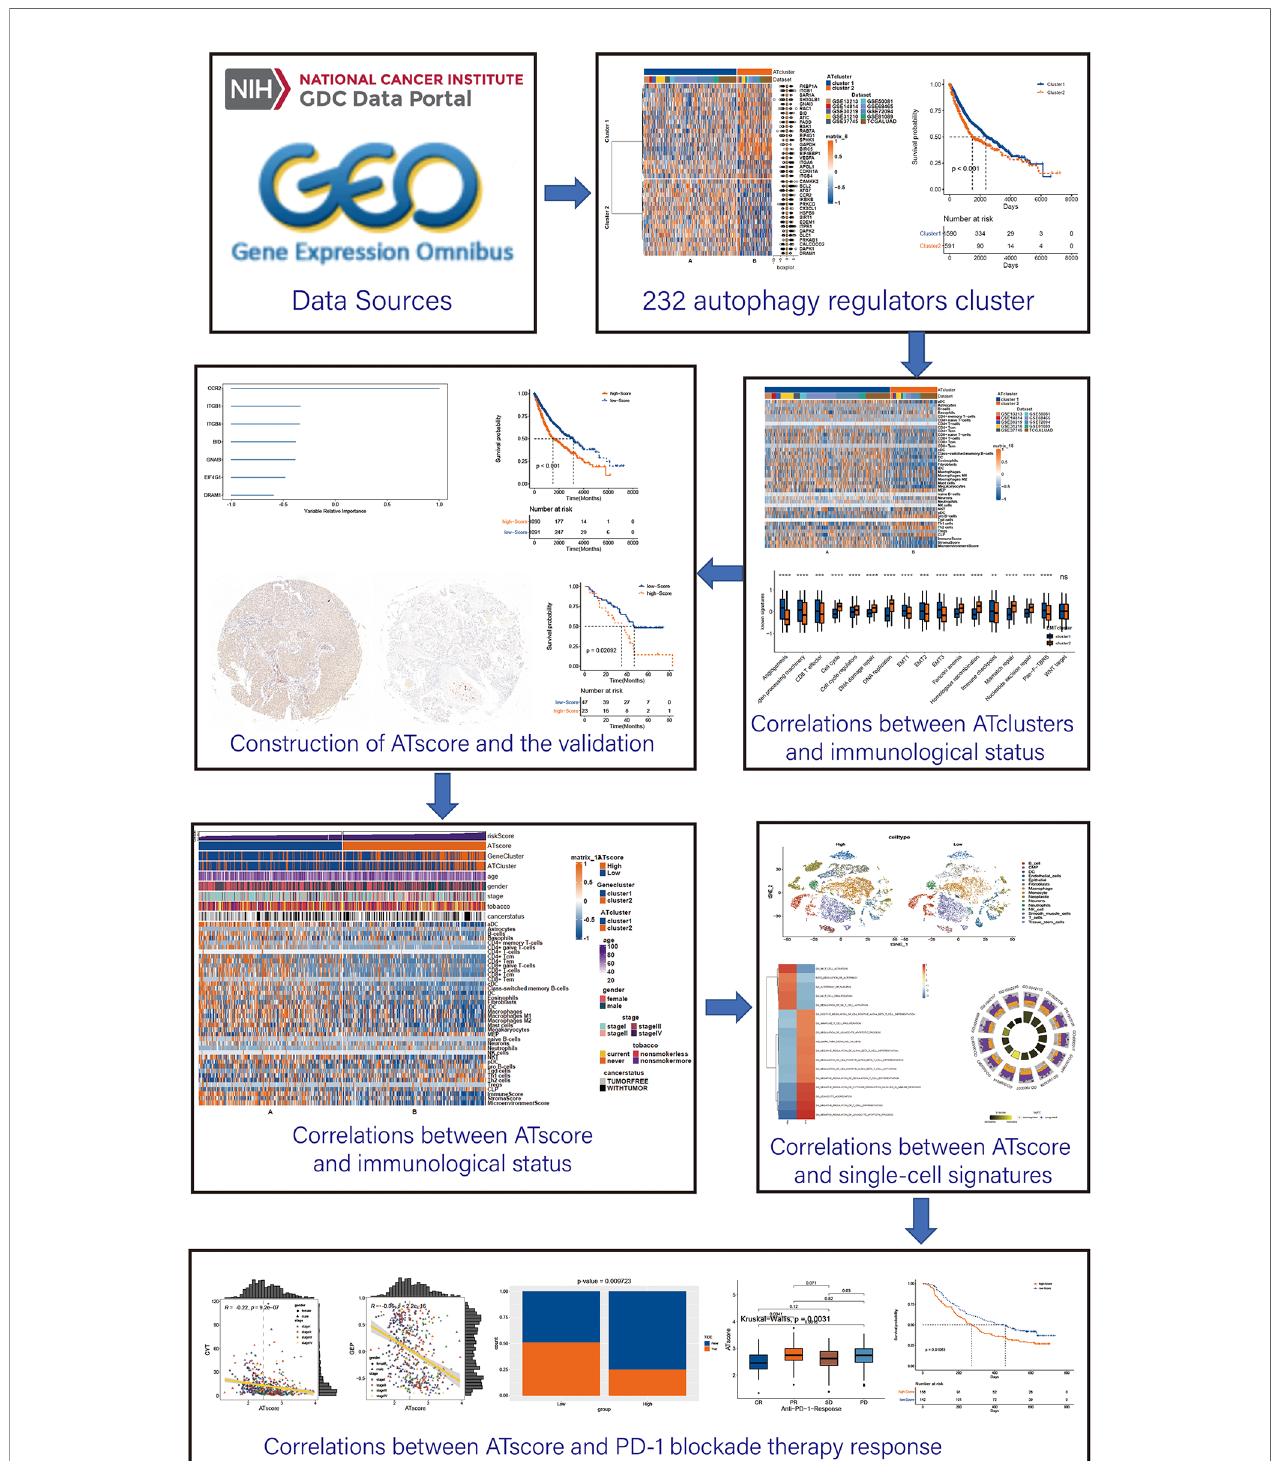
FIGURE 1 | The work fl ow of the bioinforamtic analysis. Datasets were obtained from TCGA and GEO databases, and Consensus clustering were performed using autophagy regulators. After identifying the correlation between the autophagy clustering and immunological status, ATscore was constructed and proven to be a prognostic predictor of LUAD patients. The correlation between ATscore and immunological status of tumor was con fi rmed in datasets and single-cell sequencing data. Moreover, the predictor value of ATscore in PD-1blockade therapy response was con fi rmed.